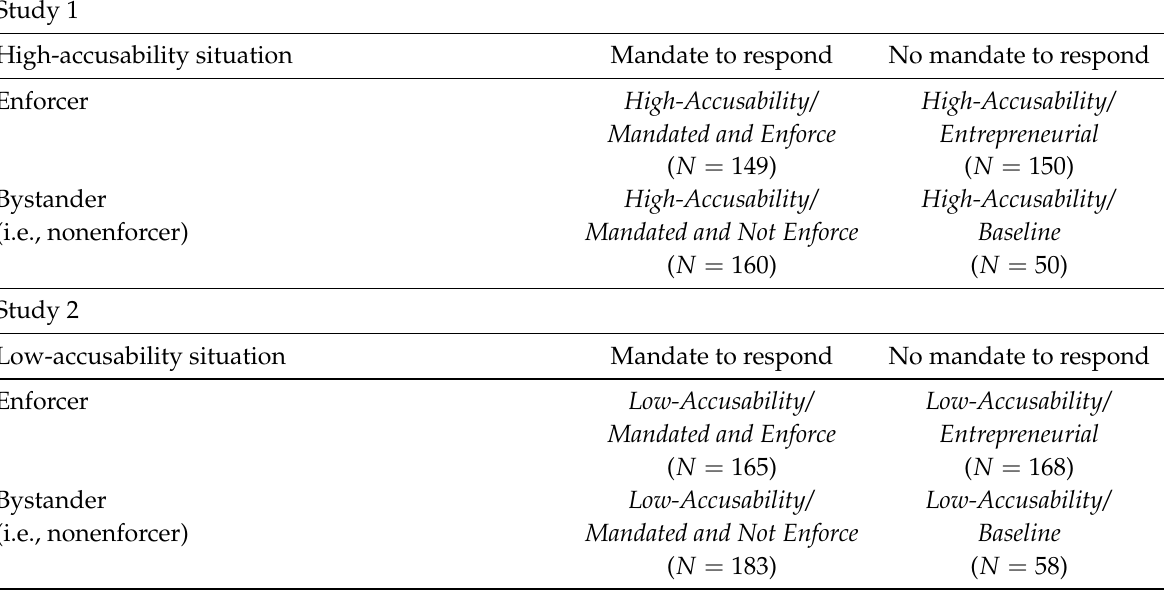
Table 2: Experimental conditions of studies 1 and